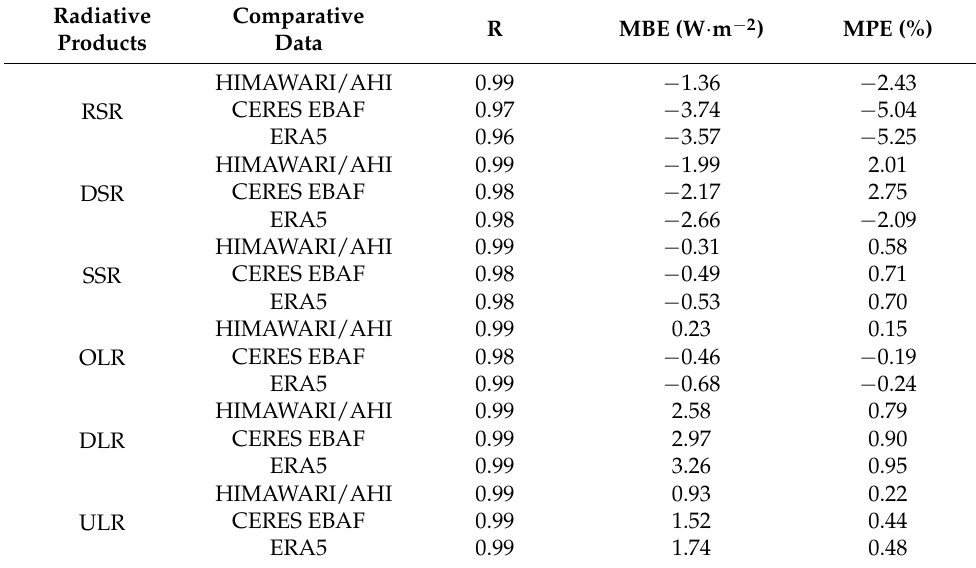
Figure 2. Accuracy analysis results for GK-2A/AMI radiative products: ( a ) RSR, ( b ) DSR, ( c ) SSR, ( d ) OLR, ( e ) DLR, and ( f ) ULR, using CERES satellite data. Data period from 1–30 September 2020. Table 2. Statistical comparison values (R, MBE, and MPE) of HIMAWARI/AHI, CERES EBAF, and ERA5 data for GK-2A/AMI radiative products. Data period from 1–31 January and 1–31 July 2021, except but HIMAWARI/AHI from 1–30 September